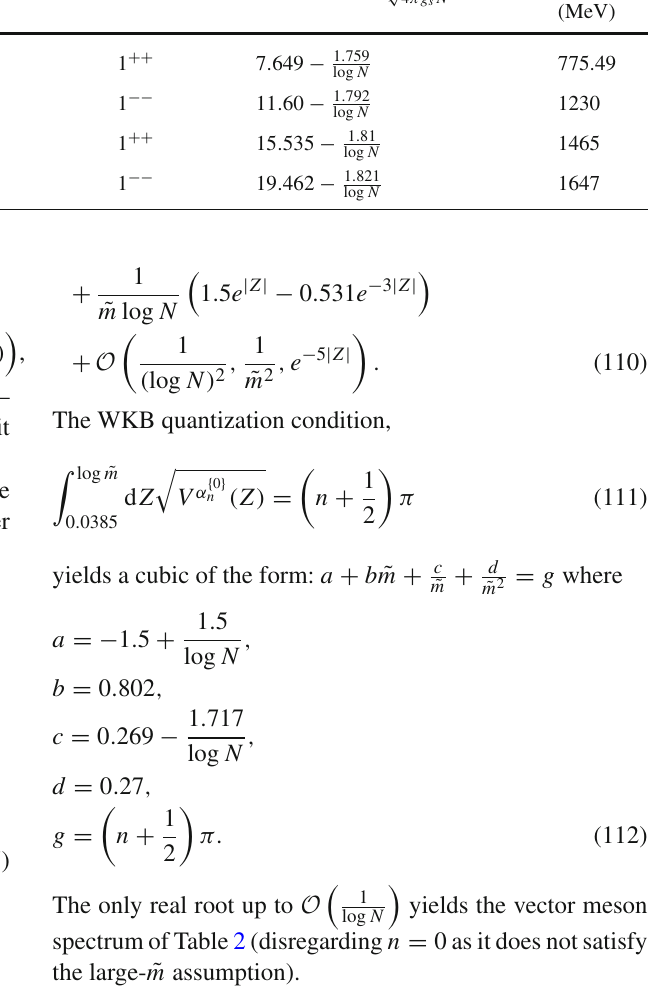
Table 1 (Pseudo-)vector meson masses from WKB